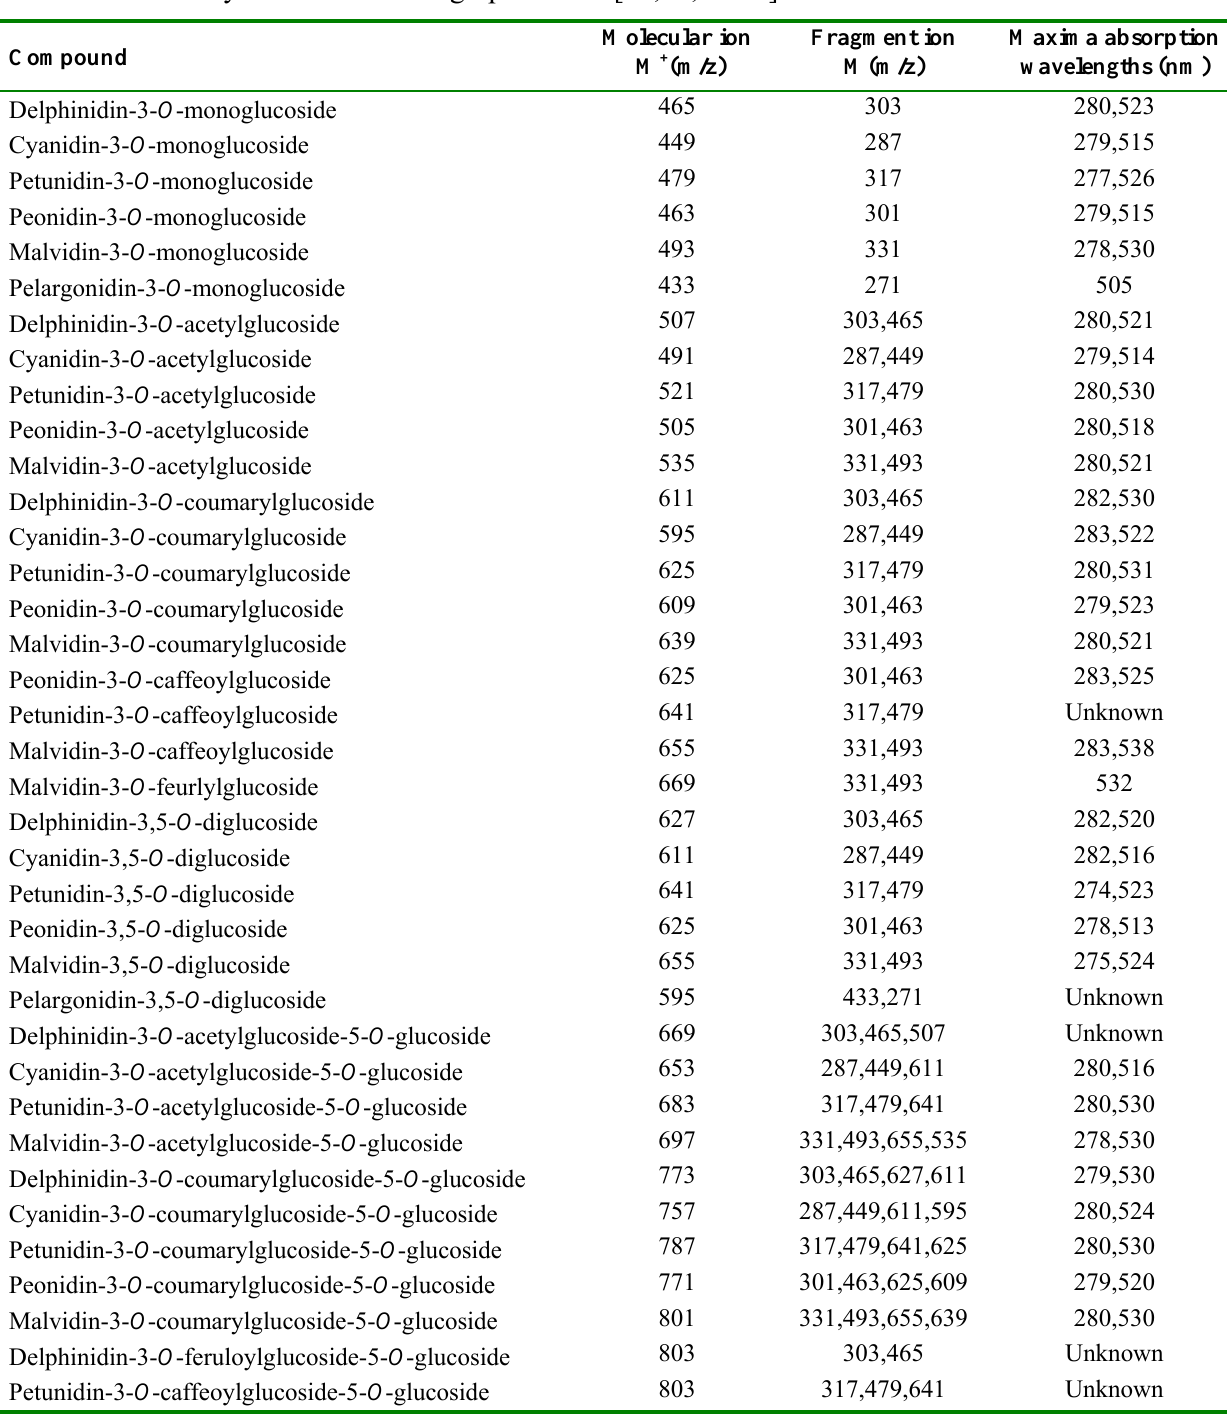
Table 1. The chromatography and mass spectrometry information of free anthocyanins that are commonly found in various grape berries